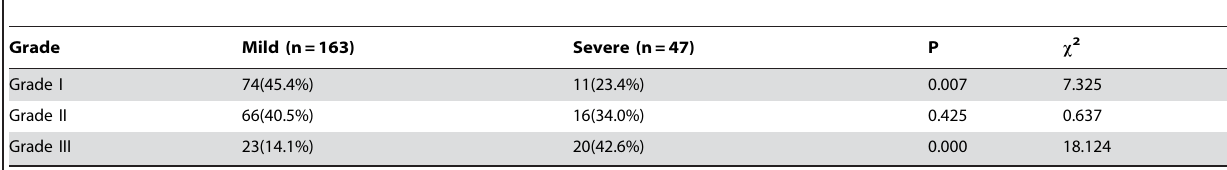
Table 3. Transverse-mesocolon involvement and the APACHE-II scoring system in patients with AP.